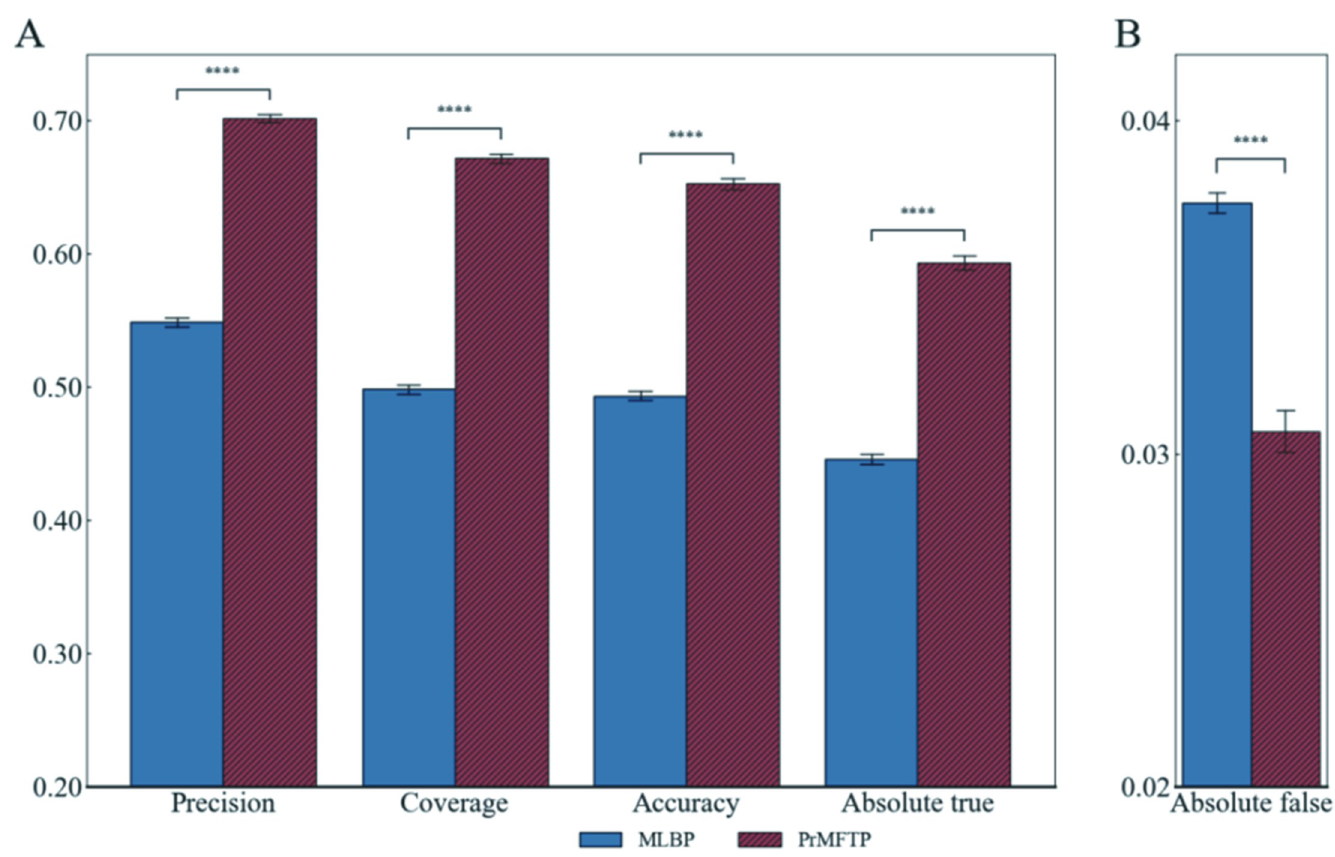
Fig 4. Performance comparison of MLBP and PrMFTP. A. Precision, Coverage, Accuracy and Absolute true; B. Absolute false. ���� mean that PrMFTP is significantly better at P-value < 0.0001 (t-test).